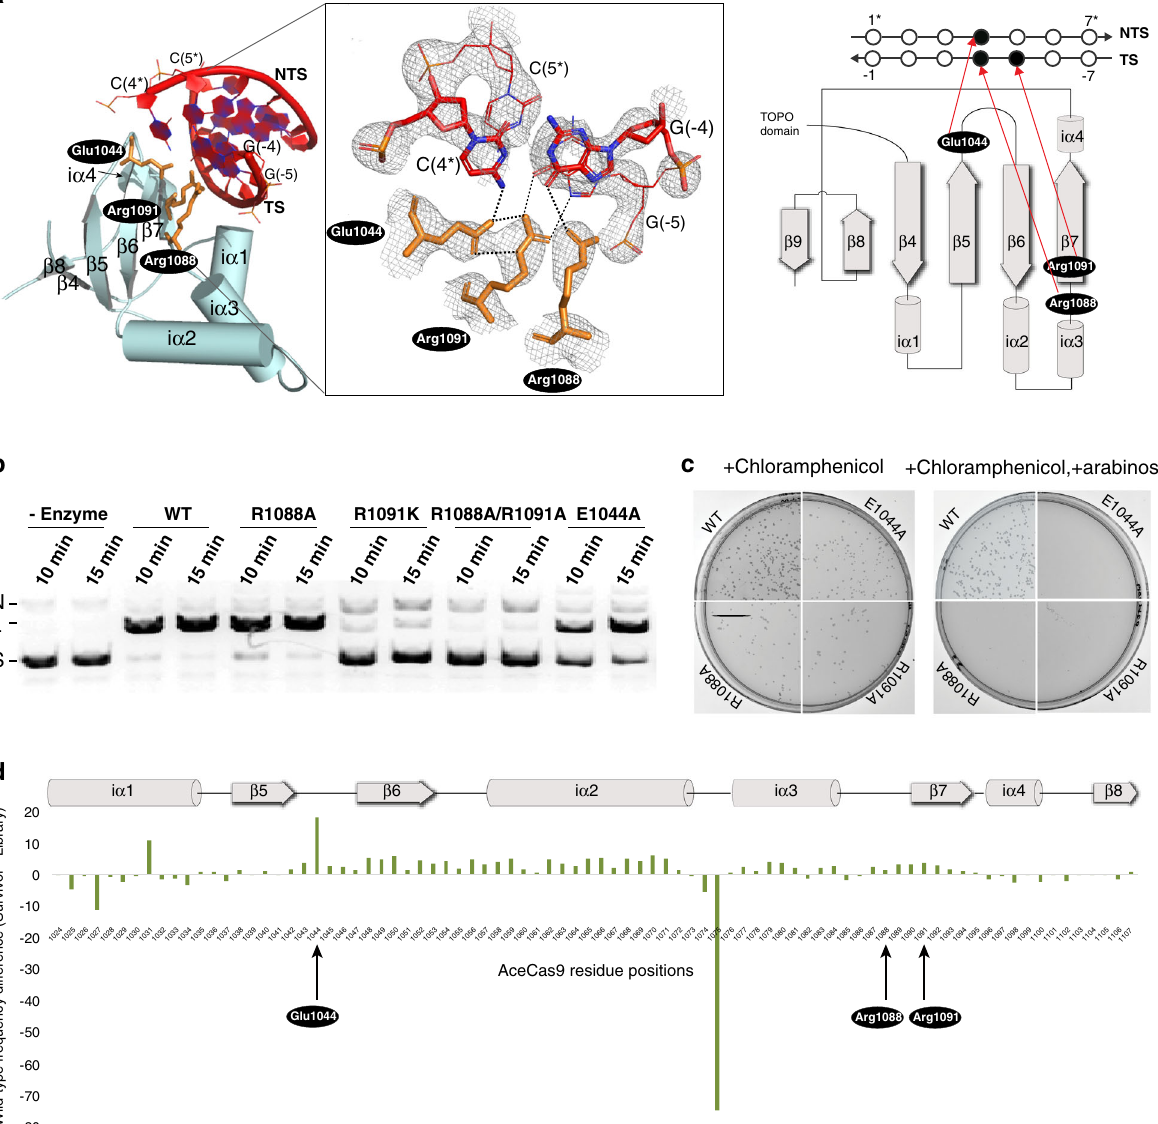
Fig. 4 Recognition of the protospacer-associated motif (PAM) by AceCas9. a Left: The structure of the PAM-interaction (PI) subdomain and its detailed interactions with the 5 ′ -NNNCC-3 ′ PAM. Inset: close-up view of PI-PAM interactions overlaid with the omit 2F o – F c map of the region. Right: Topology of the AceCas9 PI subdomain, location of the key PAM-interaction residues and the schematic interactions with the PAM nucleotides. Secondary structure elements are labeled where “ i α ” denotes insertion helices. b In vitro DNA cleavage results with the wild type (WT) and the mutants of the three PAM- interacting residues. “ L ” denotes linearized product DNA, “ S ” denotes the supercoil DNA substrate, and “ N ” denotes nicked DNA. Two reaction times for each enzyme used are indicated. c Cell survival assay results of the wild-type (WT) and three PAM-interaction mutants. d Plot of the wild-type amino acid frequency difference between that of the survivor and that of the input libraries against the residue positions. A low difference frequency indicates a high mutability and vice versa. Secondary structure elements are shown on top and denoted in same terms as in panel ( a ). The DNA cleavage experiments shown in panels ( b ) and the survival assay shown in ( c ) have been repeated more than three times with similar results. Source data are provided as a Source data fi